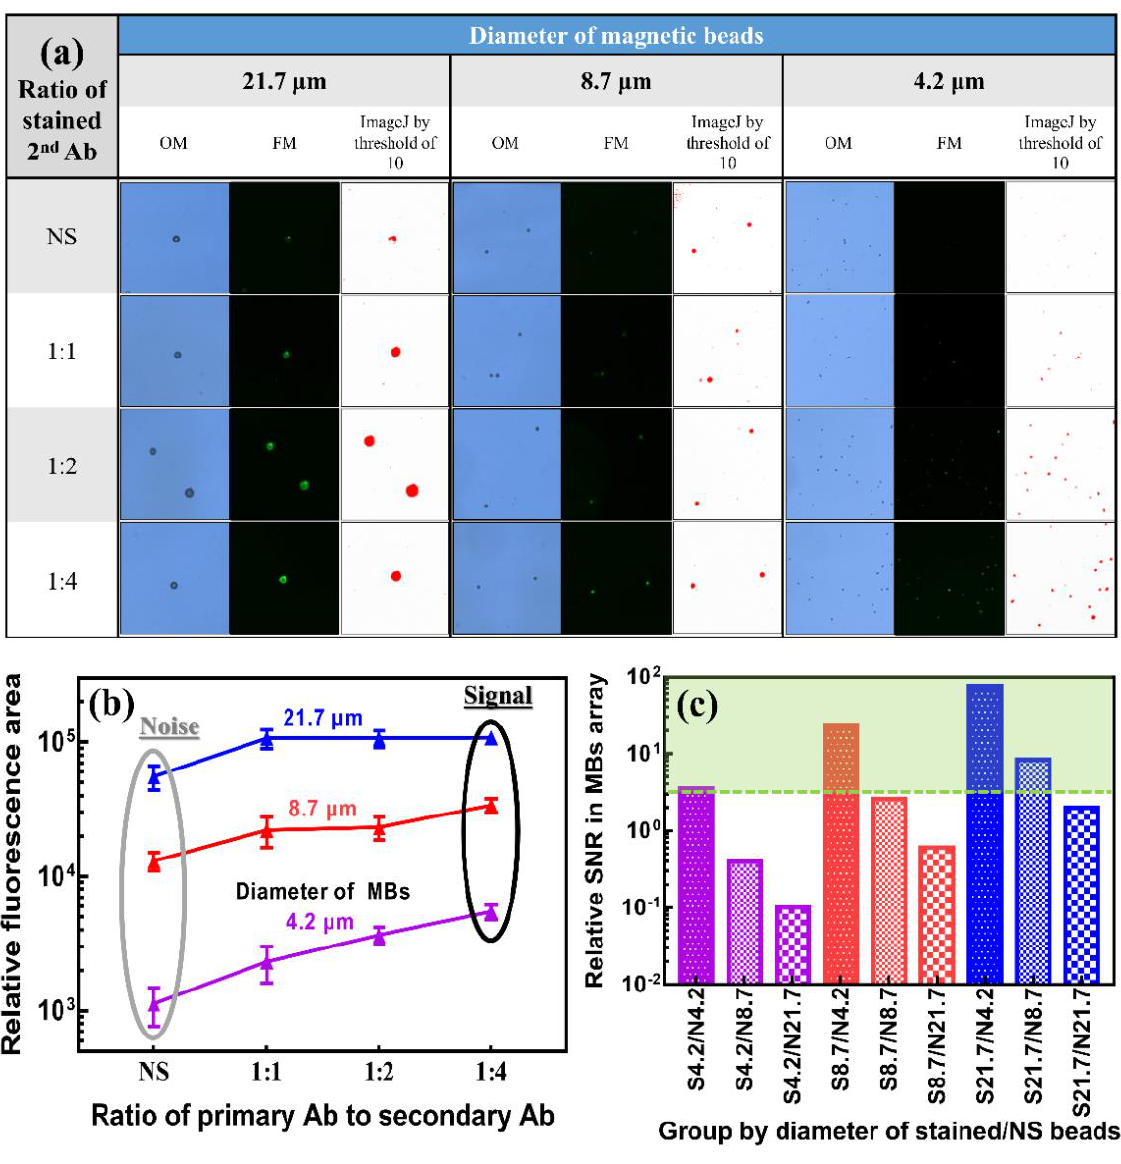
Figure 5. ( a ) Images under an optical microscope (OM), fluorescence microscope (FM), and ImageJ-processed with a detection threshold of 10. ( b ) Relative fluorescence area after filtering by ImageJ for magnetic beads with different diameters, including 21.7, 8.7, and 4.2 µ m, and different staining ratios between primary and secondary antibodies, including NS, 1:1, 1:2, and 1:4. ( c ) Relative SNR between the fluorescence area of stained and NS magnetic beads for different combinations of bead sizes.